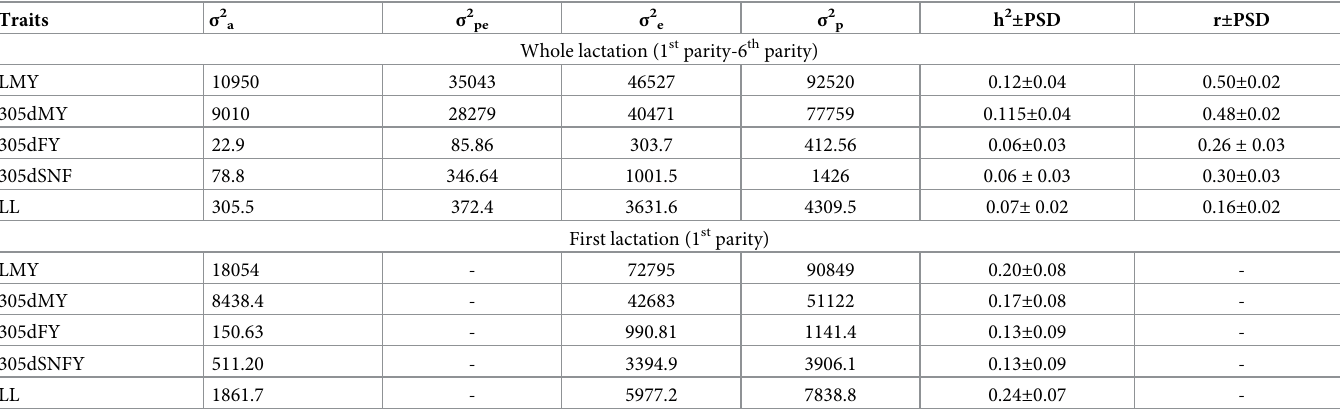
Table 5. Estimates of posterior means of variance components and genetic parameter estimates for milk production traits in Sahiwal cattle. Traits σ 2 a